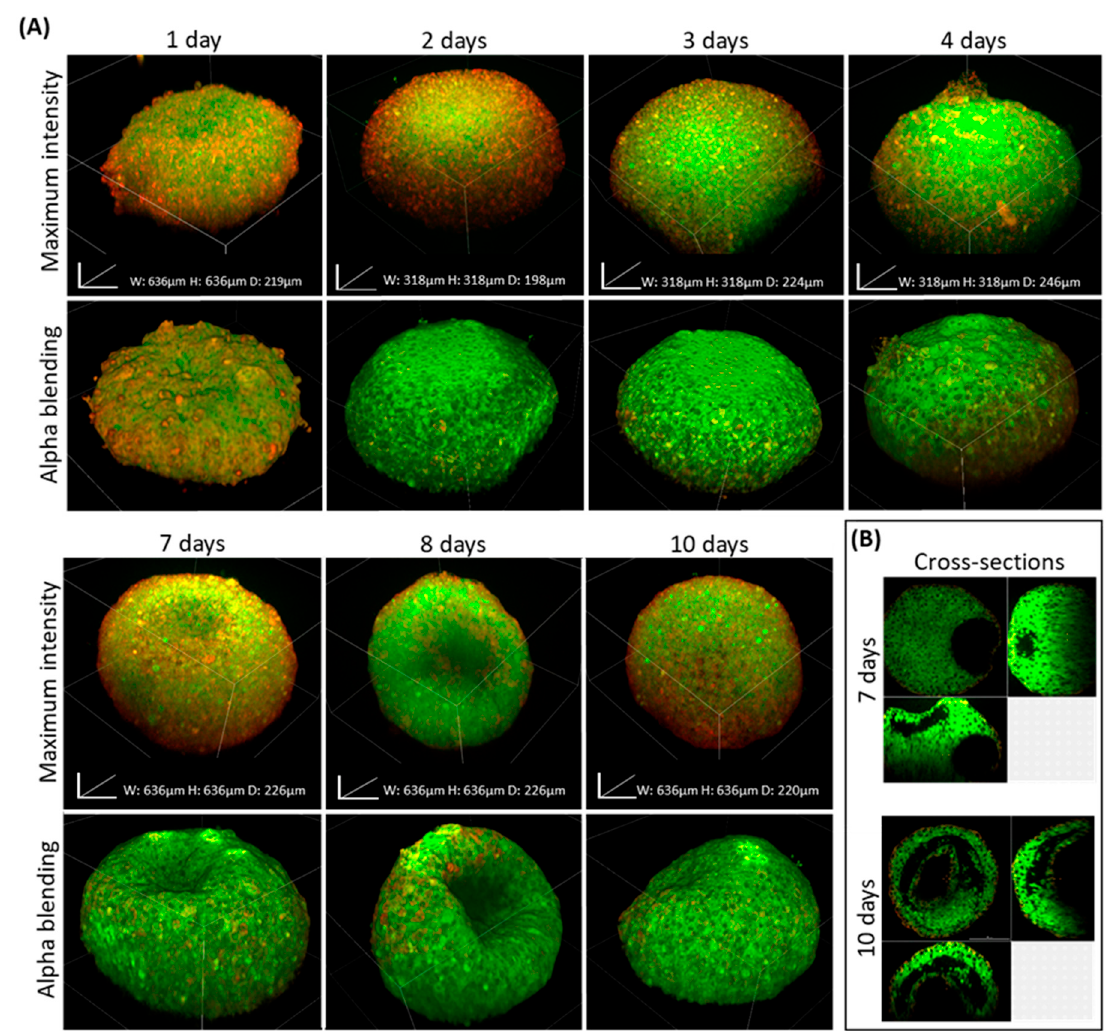
Figure 4. Dynamic 3D changes of BxPC-3 spheroids observed at predetermined time points. ( A ) Z-stacking images of BxPC-3 spheroids were reconstructed into 3D images portraying spheroids fixed at predetermined time points post-seeding: 1, 2, 3, 4, 7, 8, and 10 days and stained with Coumarin-6 (green) and DiD (red) (the day 3 image is the same cleared spheroid shown in Figure 2A). ( B ) Cross-sections of spheroids fixed at day 7 and 10, showing a retained outer structure with progressive hollowing of the core.